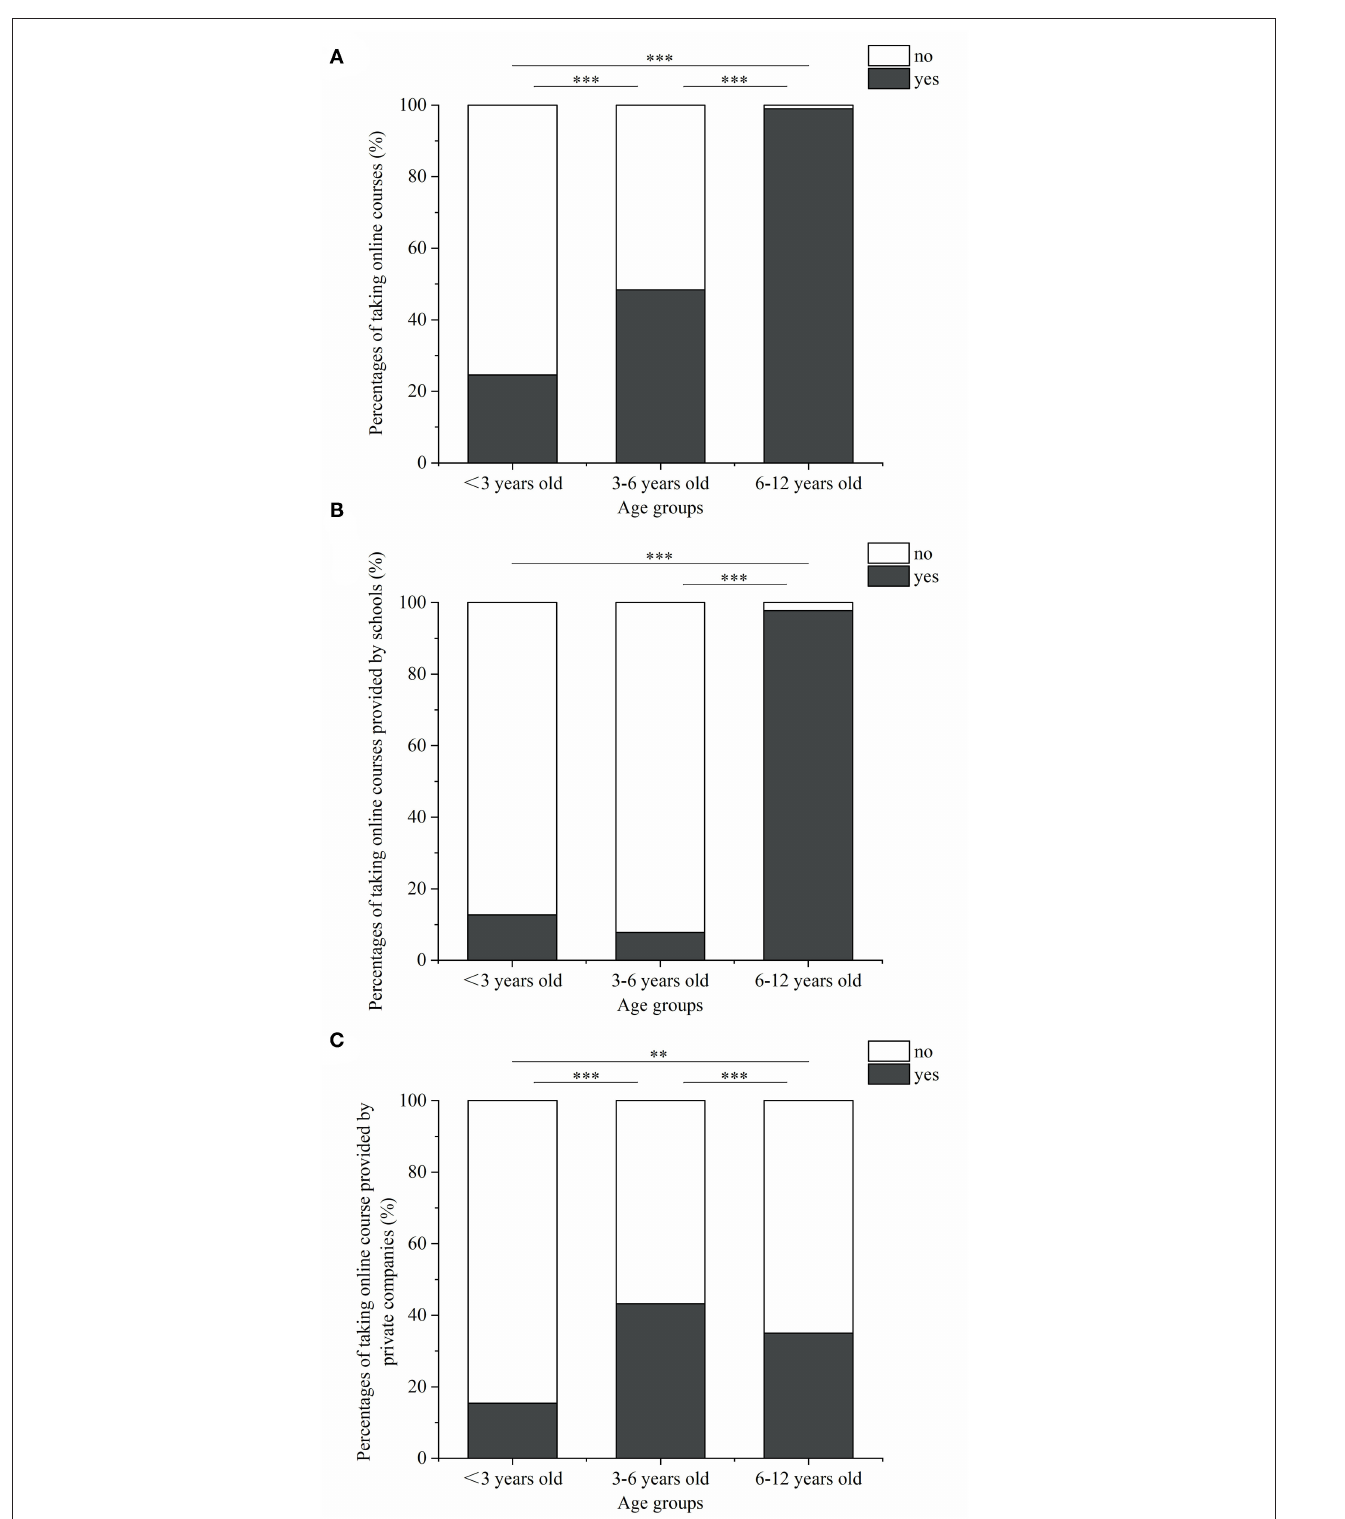
FIGURE 3 | The current situations of child taking online courses. (A) Percentages of taking online courses; (B) percentages of taking online courses provided by school; (C) percentages of taking online courses provided by private companies. ** P < 0.01; *** P < 0.001.